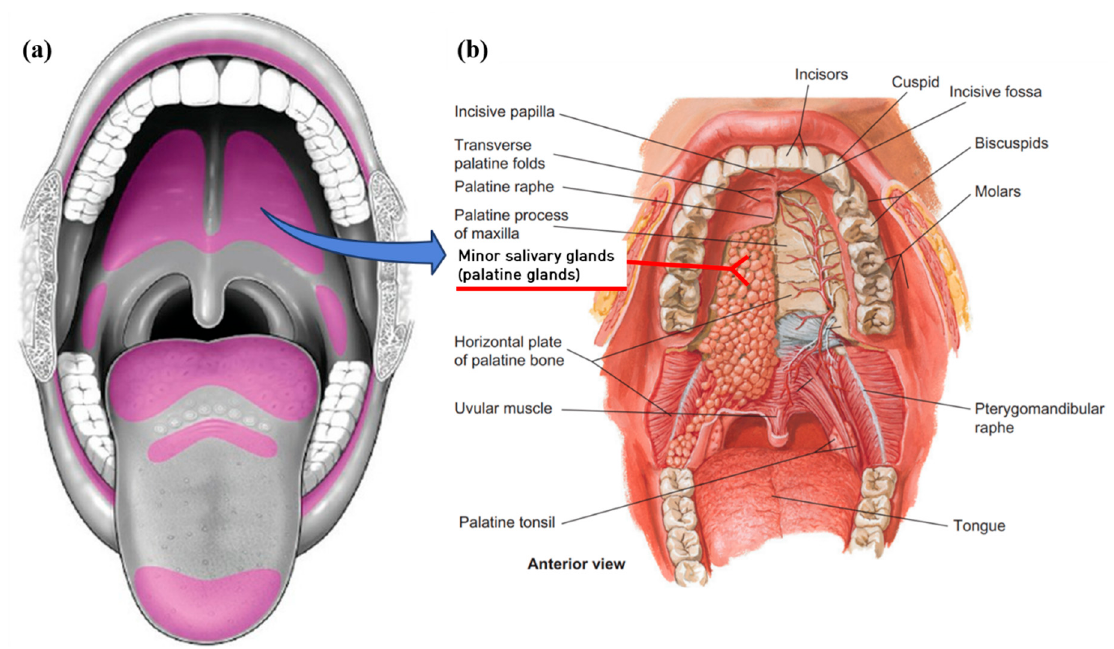
Figure 2. ( a ) Minor salivary gland distribution in the oral cavity (shown as purple shade). Adapted with permission of Wolters Kluwer Medknow Publications from Review of the Major and Minor Salivary Glands, Part 1: Anatomy, Infectious, and Inflammatory Processes, 8, 1, 2018 [31]. ( b ) Minor salivary gland are located just below the oral epithelium (Adapted with permission of Elsevier Science and Technology Books from Comparative Anatomy and Histology: A Mouse, Rat, and Human Atlas , 2017 [32]). ( a , b ) Permission conveyed through Copyright Clearance Center, Inc.